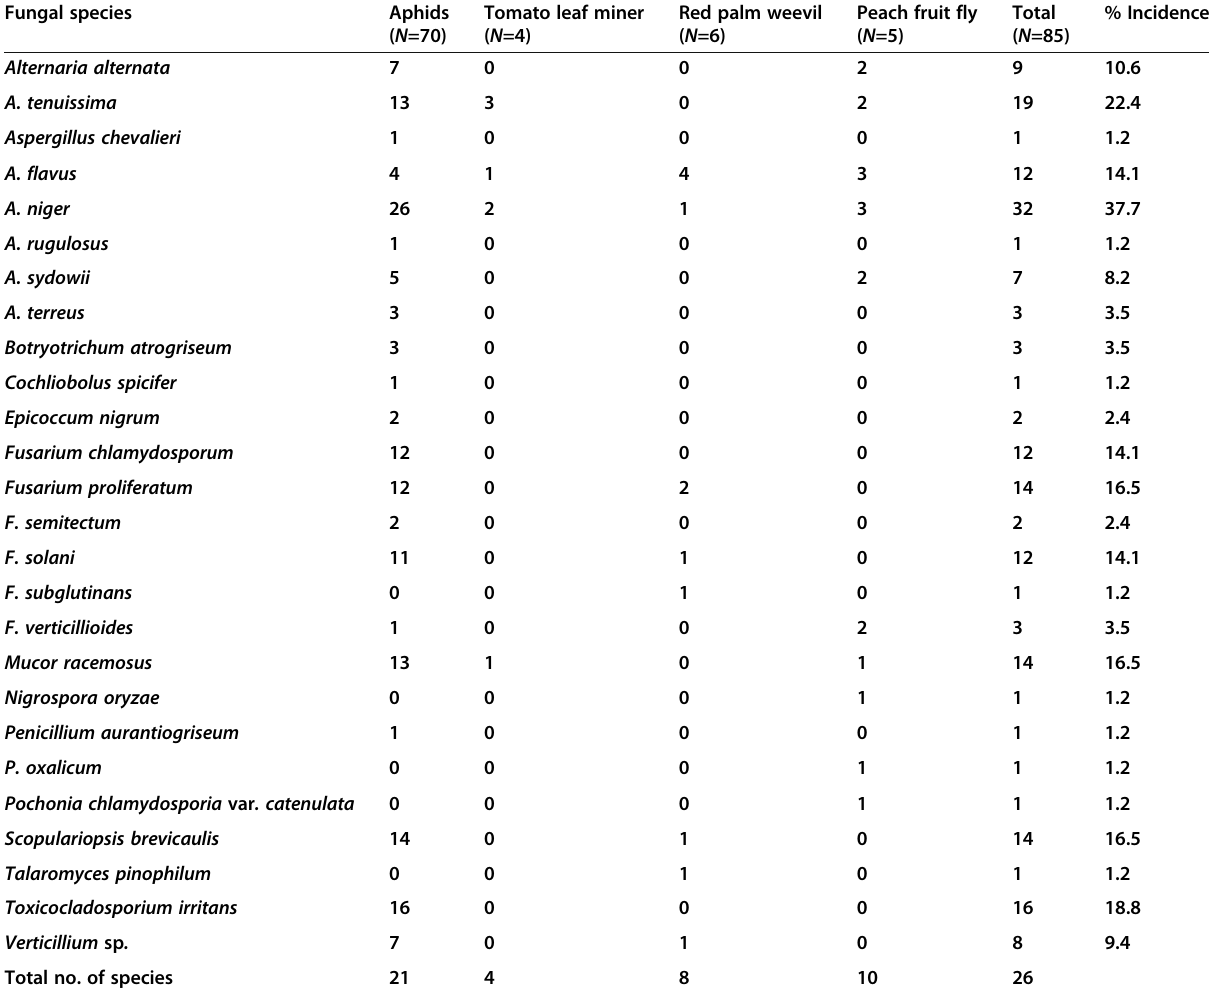
Table 1 Incidence of fungal species isolated from the tested insects Fungal